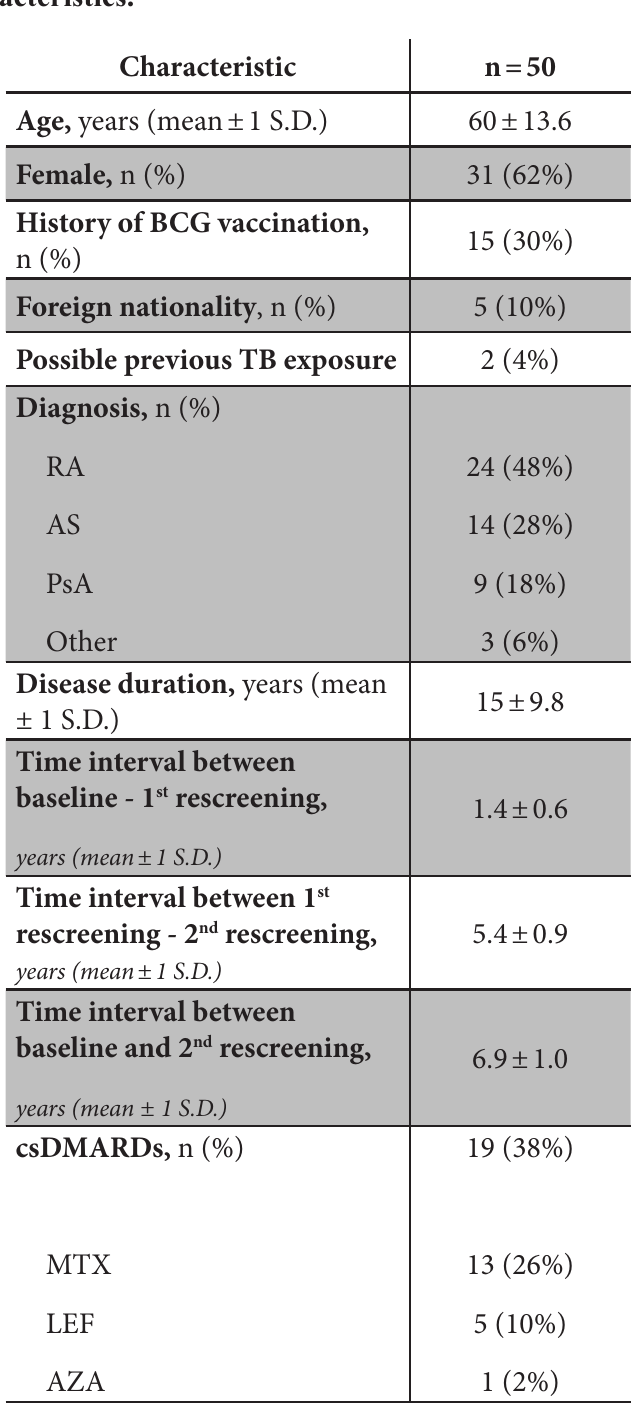
Table 1. Patient